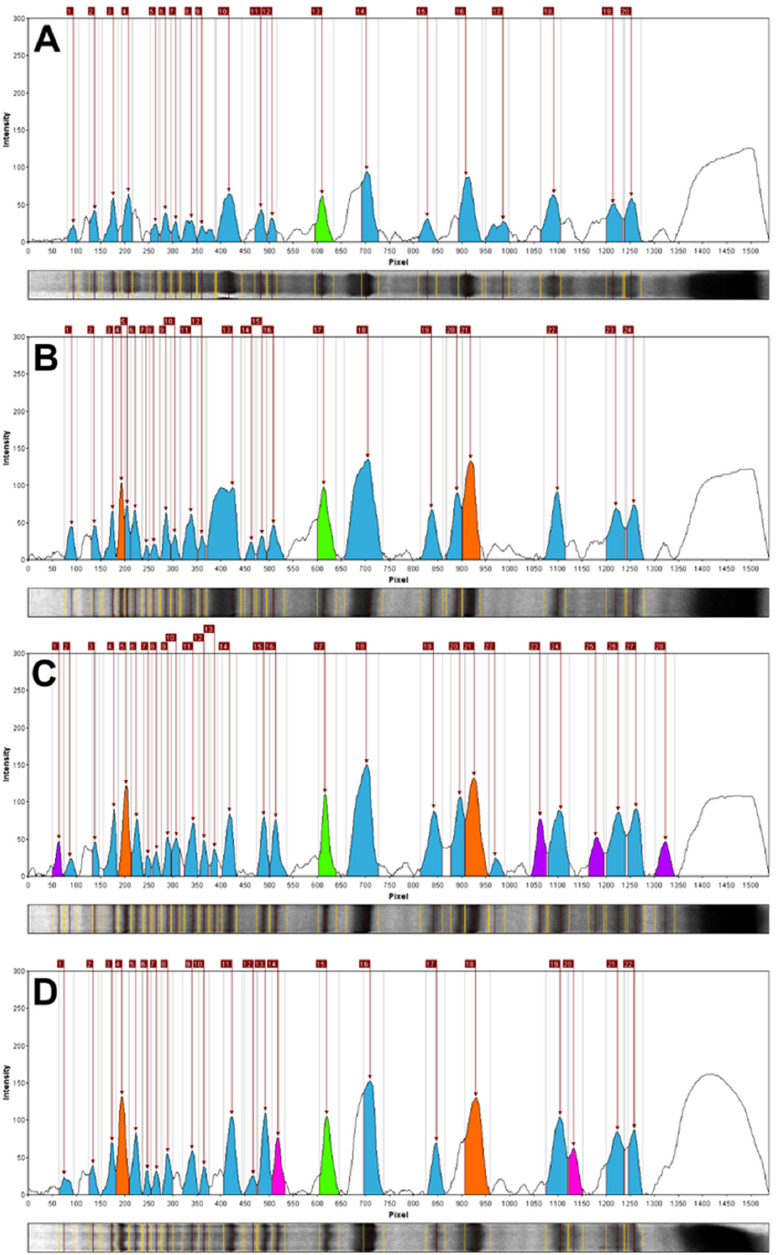
Figure 2. Relative line image plots (densitograms) based on the STP profiling. ( A ): Pinus sylvestris, ( B ): Pinus × rhaetica , ( C ): Pinus uliginosa, and ( D ): Pinus mugo. Color code: orange—specific and semi specific bands for the Pinus mugo complex members (Rf = 0.13 and Rf = 0.60); green—a band specific to the Pinus section (Rf = 0.40; purple—diagnostic bands for Pinus uliginosa (Rf = 0.04, 0.69, 0.77, and 0.86); magenta—bands specific for Pinus mugo (Rf = 0.34 and 0.74); blue—represents the other bands identified in the given profile.